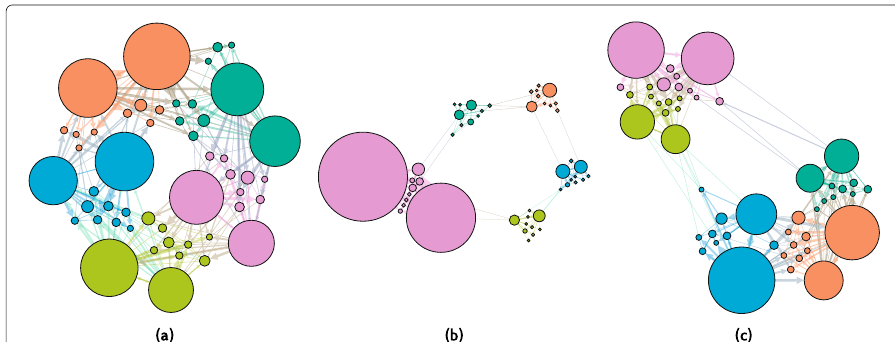
Fig. 4 Realisations from a block-constrained configuration model obtained by fixing the out-degree distribution and varying the parameters within the block-matrix B . Each realisation is obtained from a BCCM with N = 50 vertices and m = 500 directed edges. The out-degree distribution of the vertices in each block follows a power-law distribution with parameter α = 1.8 The vertices are separated into 5 equally sized blocks and the structure of the block-matrix B is given by Eq. 10, but in each graph the values of some of the are changed. On left side, a is a realisation from a BCCM where the between-block parameters ω b i b j parameters are increased to 1. In the center, b is a realisation obtained by increasing the parameter ω b controls for the internal cohesion of the first block. On the right side, c is a realisation obtained by increasing to 0.8 the between-block parameters ω b visualised using the force-atlas2 layout with weighted edges. Out-degrees determine vertex sizes, and edge widths the edge